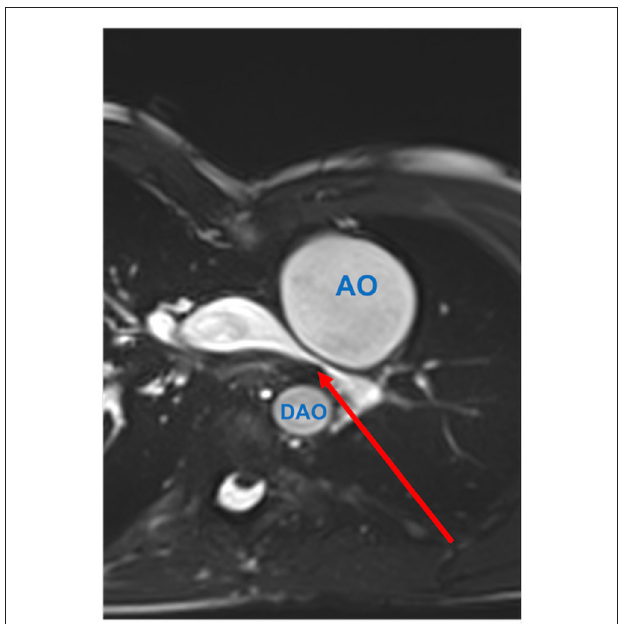
FIGURE 1 | Pulmonary artery stenosis (red arrow) seen by CMR. Axial SSFP-cine view shows the left pulmonary artery is compressed between the dilated aortic root (AO) and the descending aorta